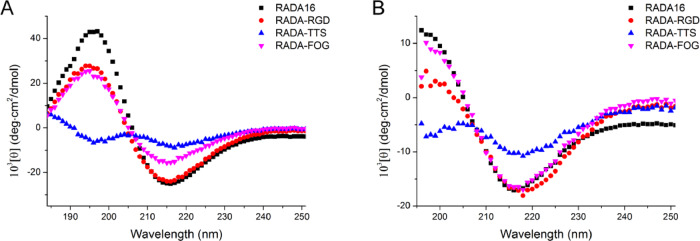
Secondary structures of the peptides RADA-RGD, RADA-TTS, RADA-FOG and RADA16 in (A) pure water and (B) PBS. The peptides were incubated in pure water or 50 mM PBS (pH 7.2), respectively, to give a final concentration of 0.01% wt/vol. CD spectra were recorded at 25°C.